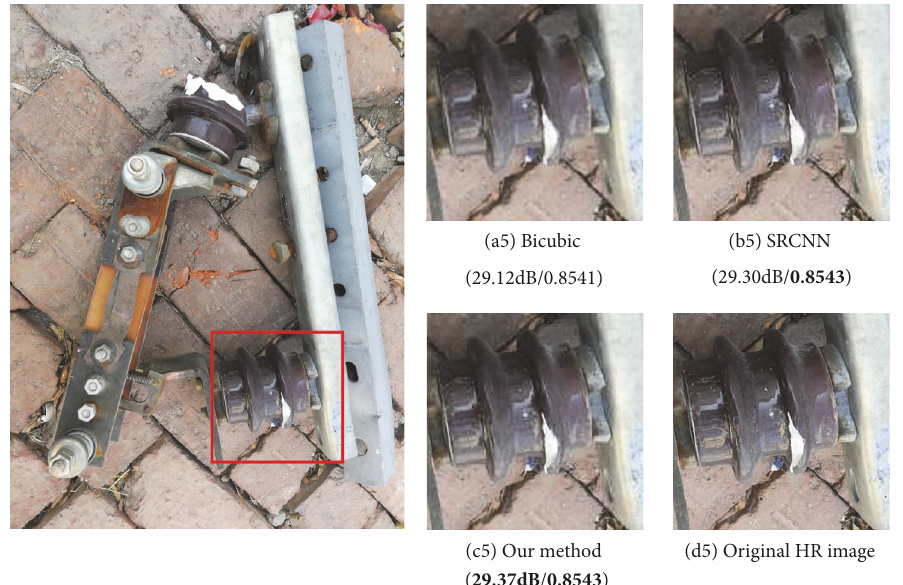
Figure 9: Insulators on low voltage knife gates.